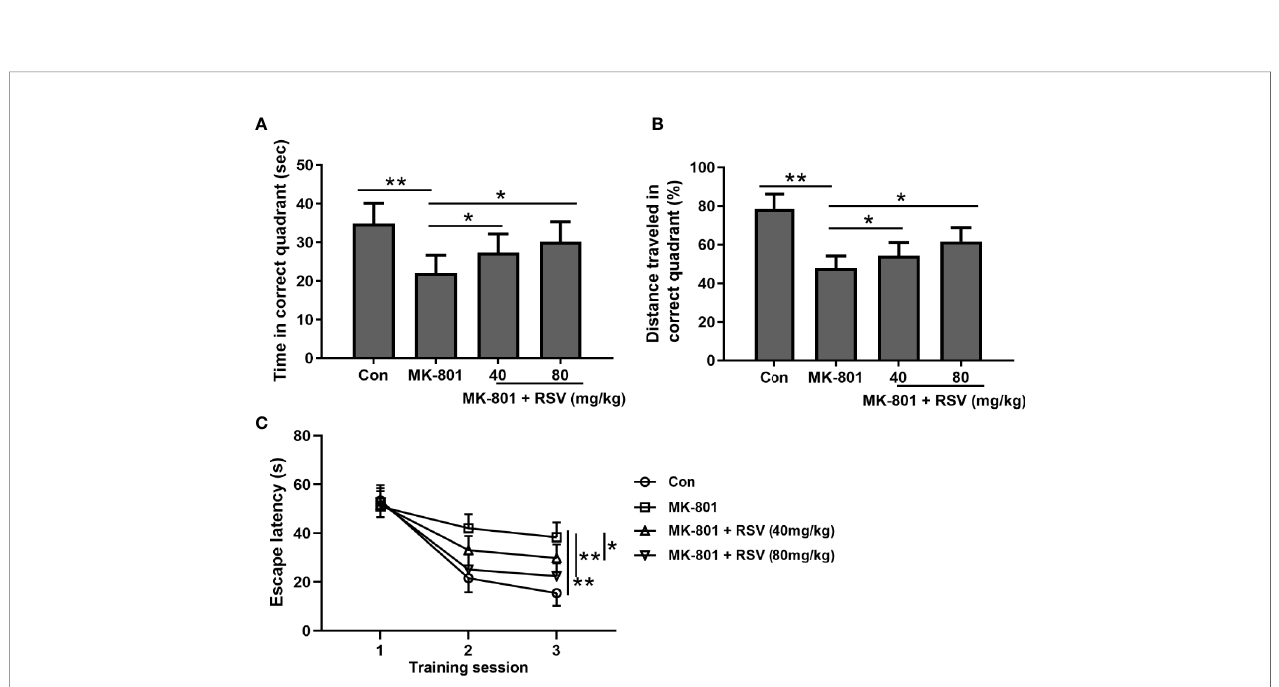
FIGURE 6 | Effect of RSV on spatial learning of rats exposed to MK-801 in the Morris water maze task. Time spent in the target quadrant (A) , distance traveled in the target quadrant (B) and escape latencies during the three training sessions (C) were compared. n = 10 in each group. Data were presented as mean ± SD. F ratios: (A) 9.172 (3.00, 17.55), (B) 28.06 (3.00, 20.34). *p < 0.05, **p < 0.01 between the indicated groups.